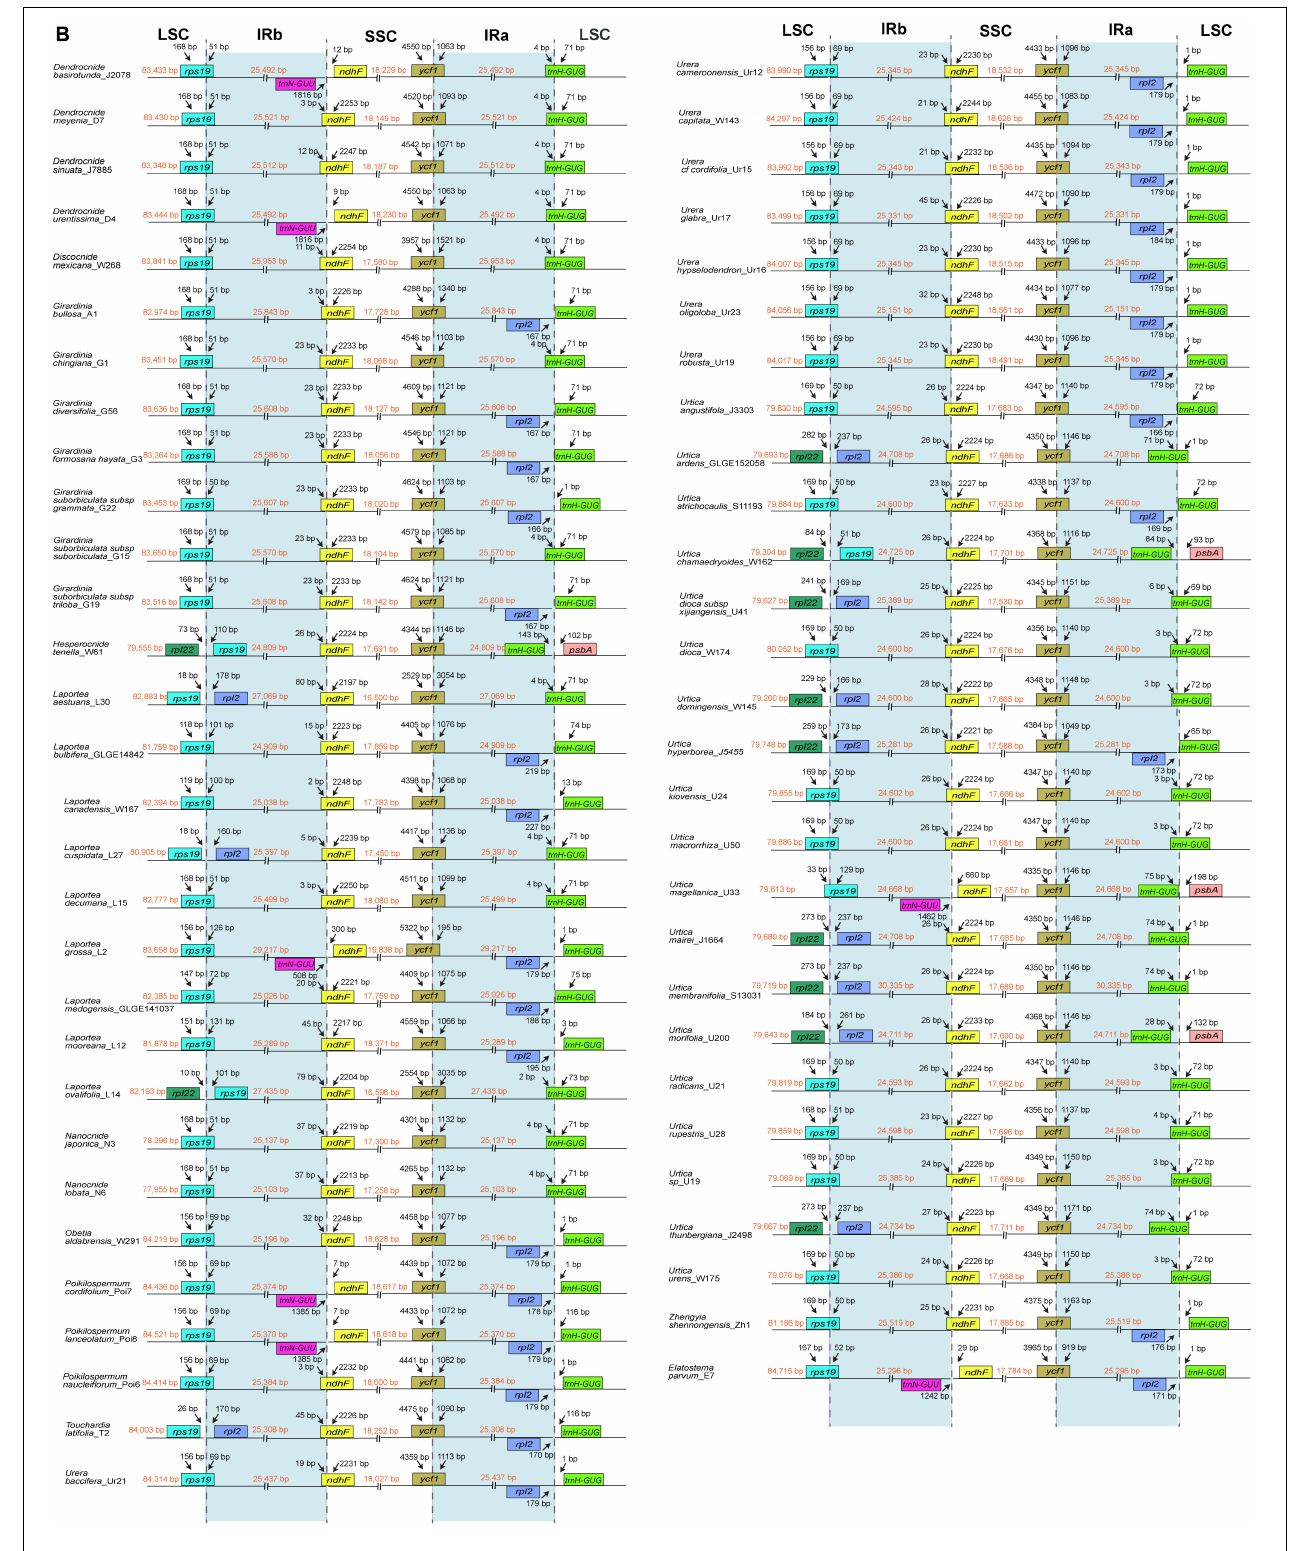
FIGURE 3 | (A) representative map showing expansions and contractions in the IR region; (B) comparison of the IR/SC junctions among 57 Urticeae plastomes. The genes around the borders are shown above or below the main line. LSC, Large Single Copy; SSC, Small Single Copy; IR (a and b), Inverted Repeat a and b.